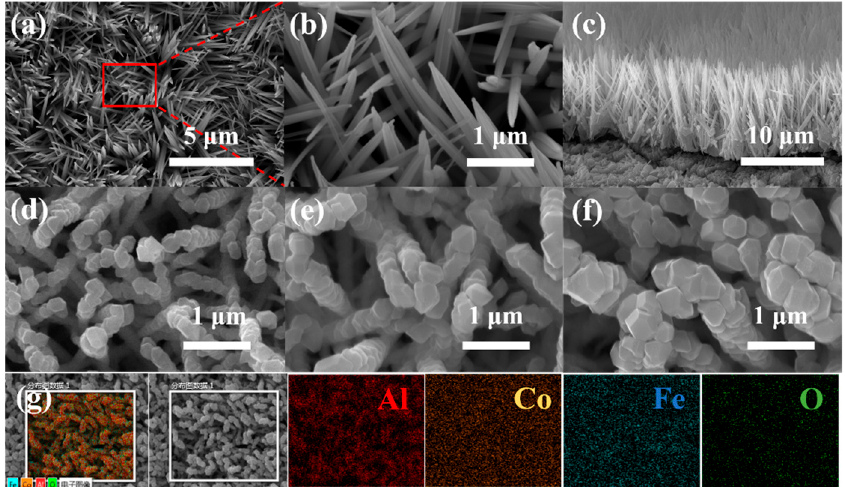
Figure 3. The scanning electron microscopy (SEM) images of the ( a , b ) CoFe 2 O 4 NWs film, ( c ) CoFe 2 O 4 NWs film from the side view, ( d ) CoFe 2 O 4 / Al NWs nanothermite film (Al = 200 nm), ( e ) CoFe 2 O 4 / Al NWs nanothermite film (Al = 400 nm), ( f ) CoFe 2 O 4 / Al NWs nanothermite film (Al = 600 nm) and ( g ) elemental mappings of CoFe 2 O 4 / Al NWs nanothermite film (Al = 400 nm).